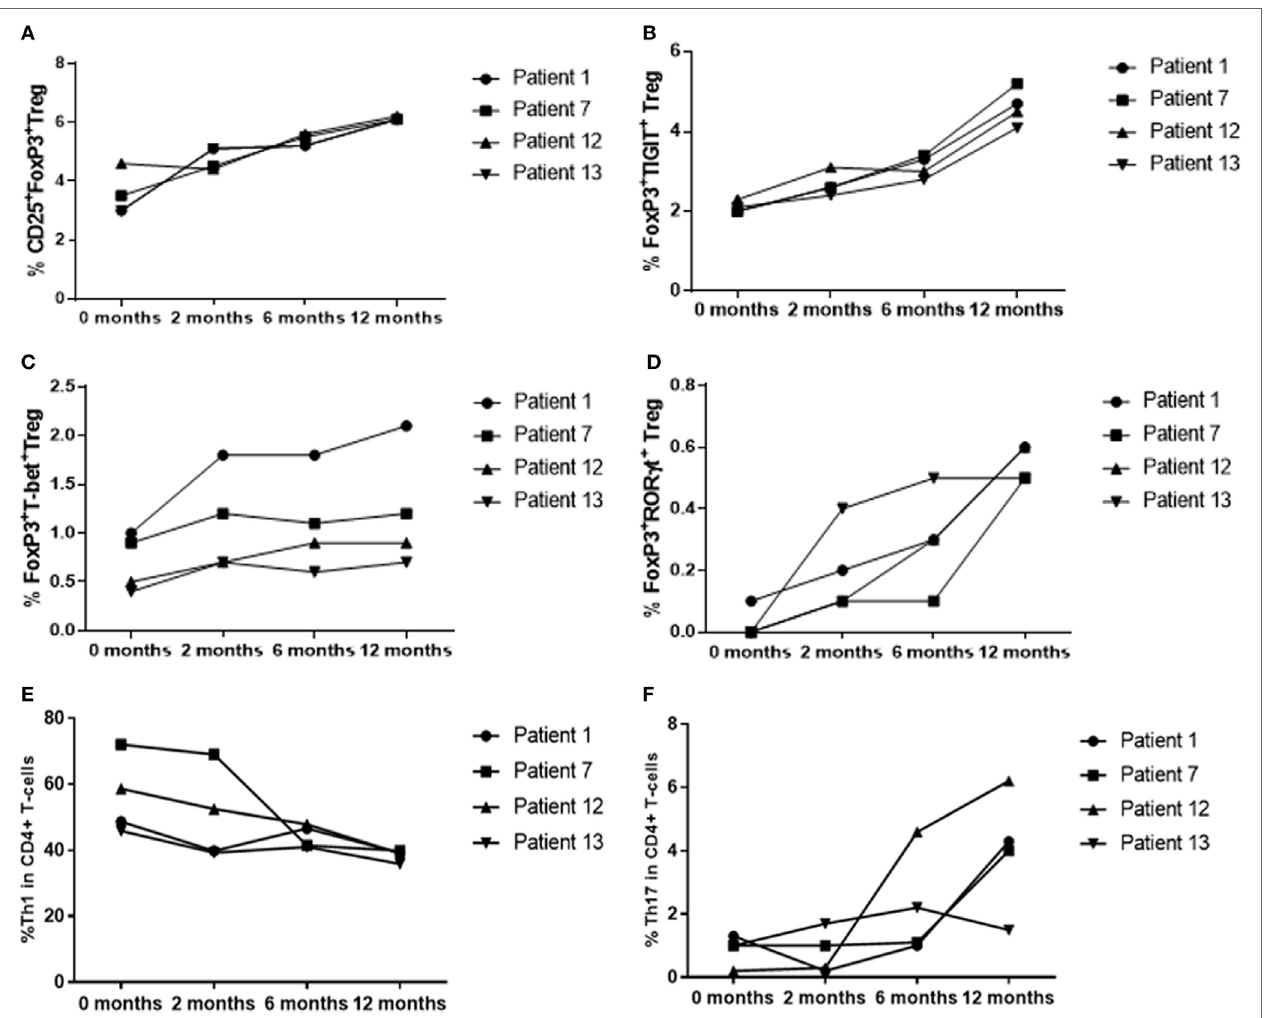
FigUre 6 | T-regulatory cell (Treg), Th1 and Th17 % levels in patients with active disease at baseline, as disease resolved over 12 months of treatment with oral immunosuppression. (a) CD25 + FoxP3 + Treg. (B) CD25 + FoxP3 + TIGIT + Treg. (c) FoxP3 + T-bet + Treg. (D) FoxP3 + ROR γ t + Treg. (e) CD4 + T-bet + Th1. (F) CD4 + ROR γ t +